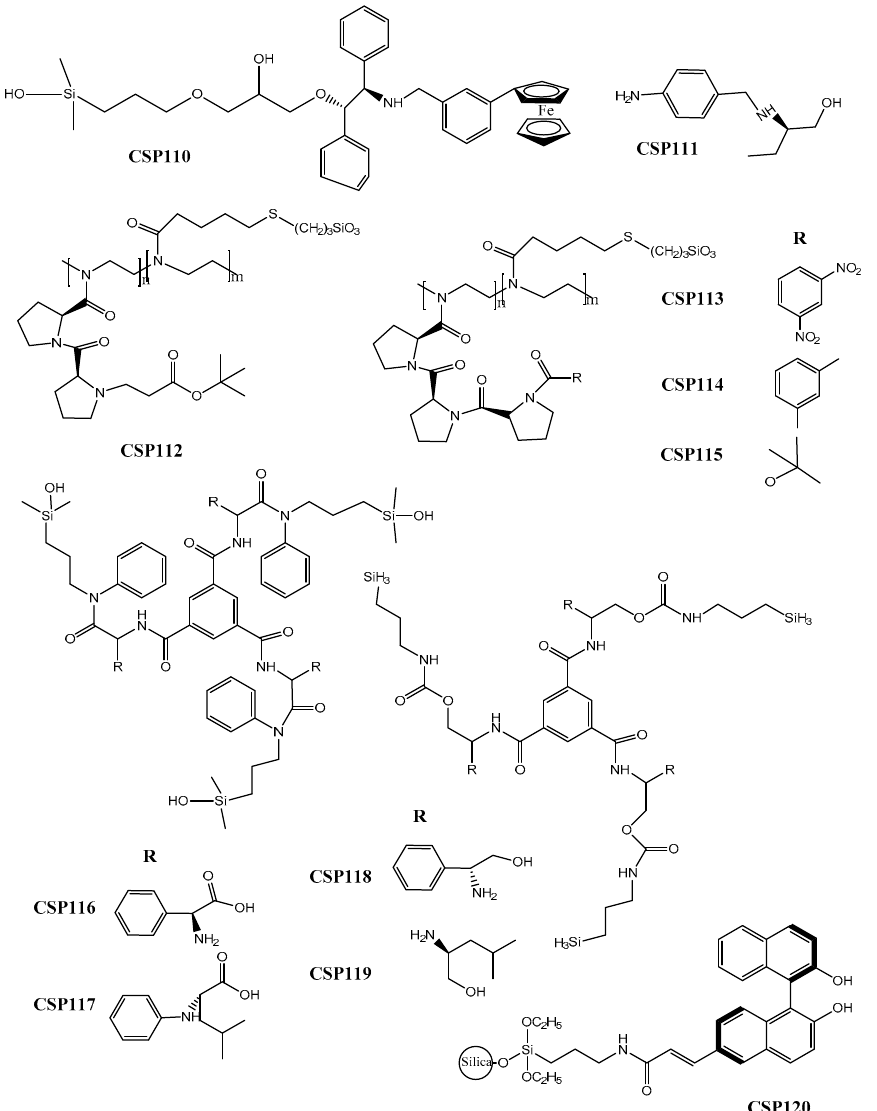
Figure 4. Chemical structures of Pirkle-type CSP110–120.